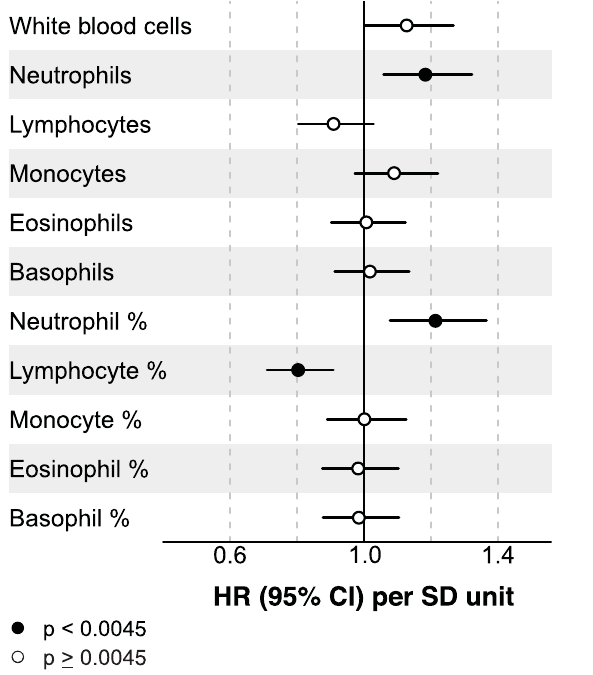
Fig 1. Each of the 22 hematological parameters was analyzed separately. HRs are given per SD-unit increase adjusted for all SRS variables. CI: confidence interval; HR: hazard ratio; MCH: mean corpuscular hemoglobin; MCHC: mean corpuscular hemoglobin concentration; MCV: mean corpuscular volume; MPV: mean platelet volume; PDW: platelet distribution width; RDW: red cell distribution width; SD: standard deviation; SRS: SMART risk score. (cid:3) A quadratic term was added for hematocrit. Significance test for quadratic polynomial after adjustment for all SRS variables: χ 2(df = 2) = 6.2; p = 0.045.